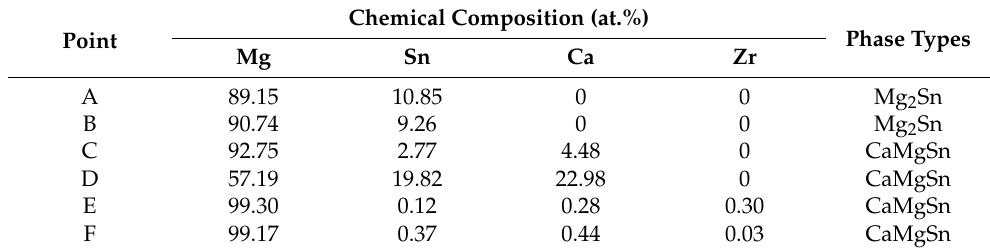
Table 3. EDS results of as-extruded T3, TX31, and TXK311